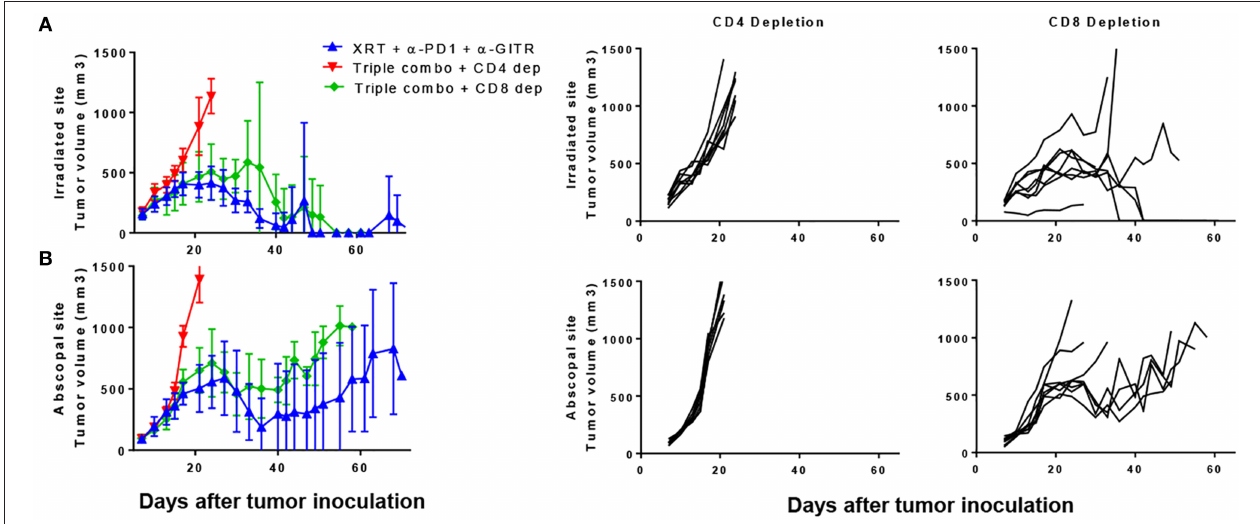
FIGURE 5 | The combination of PD1, GITR, and radiation requires CD4 + T cells and partially CD8 + T cells. Mice were inoculated with primary and secondary tumors and were treated with XRT, anti-PD1, and anti-GITR, similar to previous experiments. Starting on day 6 post inoculation, depleting antibodies were administered, initially with a bolus of 500 ug and then once weekly with 200 ug. Anti-GITR therapy started on day 7 followed by XRT and PD1 on day 8. (A) Primary and (B) secondary tumors are shown from the groups ( n = 7). Gating strategy seen in Supplementary Figure 2